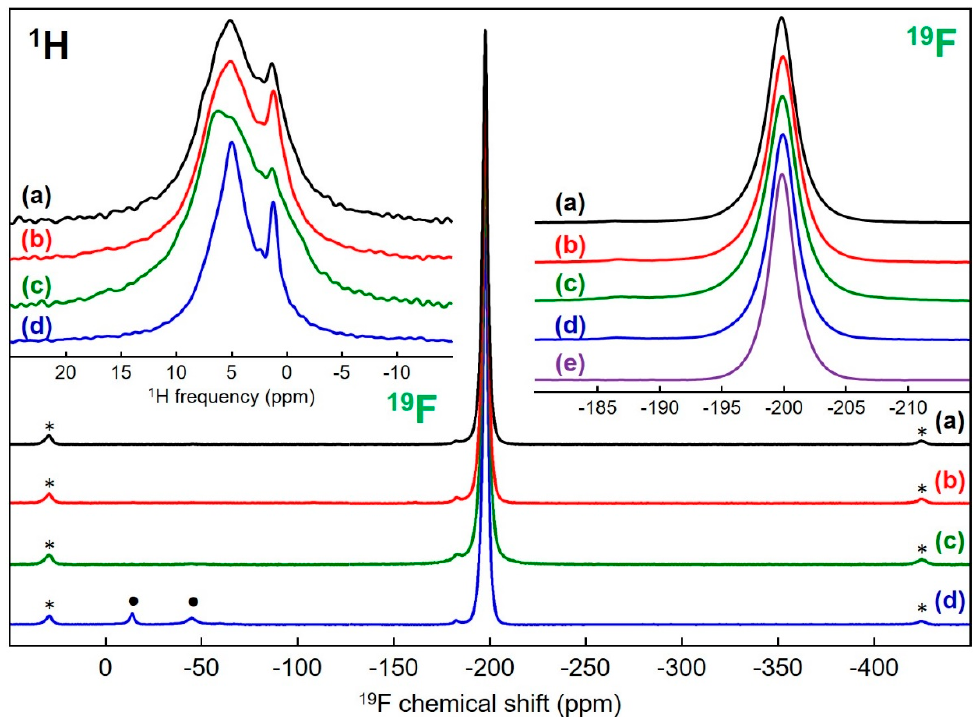
Figure 7. 19 F and 1 H (in the inset on the left) solid-state MAS (64 kHz and 60 kHz, respectively) NMR spectra of MgF 2 samples prepared from ( a ) acetate, ( b ) carbonate, ( c ) chloride and ( d ) nitrate magnesium precursors, after the HF activation step. The isotropic lines of the 19 F spectra are expanded in the inset on the right and compared with that of ( e ) a micro crystalline sample of MgF 2 recorded under the same conditions. The star symbols on the 19 F spectra indicate the spinning sidebands. The dot symbols on the 19 F spectra of ( d ) indicate fluoride impurities.